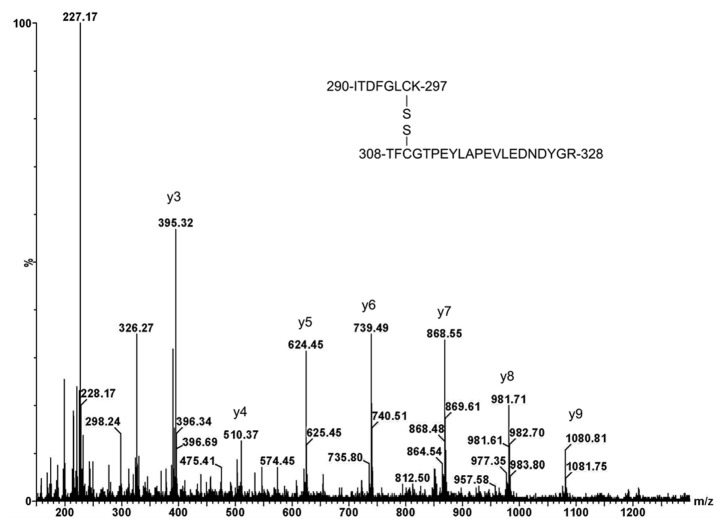
MS/MS sequence analysis of the Cys296-Cys310 disulfide-linked peptide with dephosphoryated Thr308 in soleus muscle from burned rats. Partially sequenced Cys296-Cys310 disulfide-linked dipeptides: C-terminal y ion series (y3 to y9) of Cys310-containing peptide, 308TFCGTPEYLAPEVLEDNDYGR328, were observed from the quadruply charged parent ion (T41-SS-T44, M+4H+).